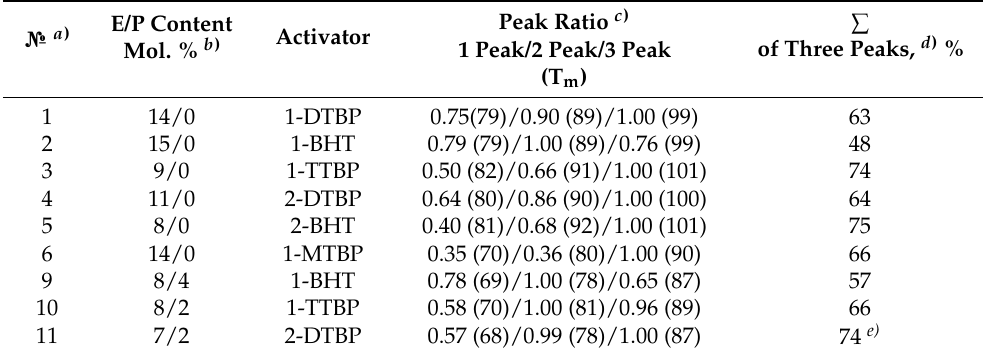
Table 2. Results of thermal fractionation of E/P and E/P/ENB copolymer